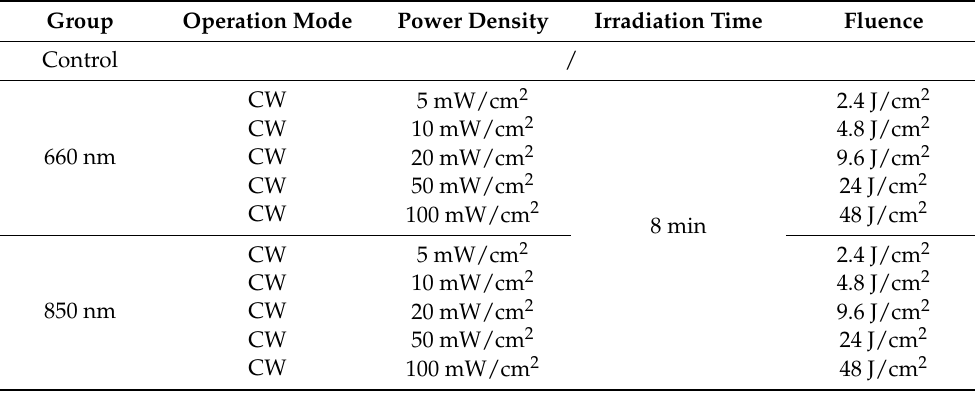
Table 2. Experimental conditions for intensity Figure 3. Layout of duplicated wells (marked in pink) in 96-well plate.